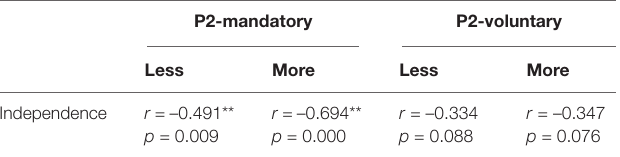
TABLE 1 | Correlation